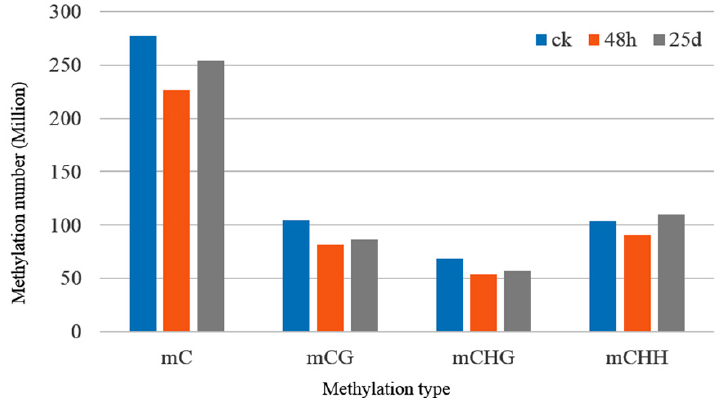
Figure 2. Numbers of mC, mCG, mCHG and mCHH identified in each sample by referring to the genome of watermelon “Charleston Gray”. “m” stands for methylated in the bases: C, G, H (either A, T or G)